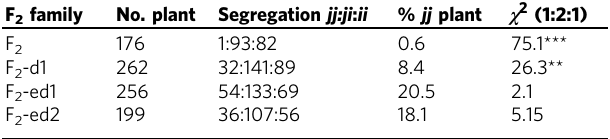
Note: jj , ii , and ji denote homozygous Sc-j , homozygous Sc-i (intact or edited), and the heterozygote, respectively. ** and ***, signi fi cance at P < 0.01 and P < 0.001, respectively, for the χ 2